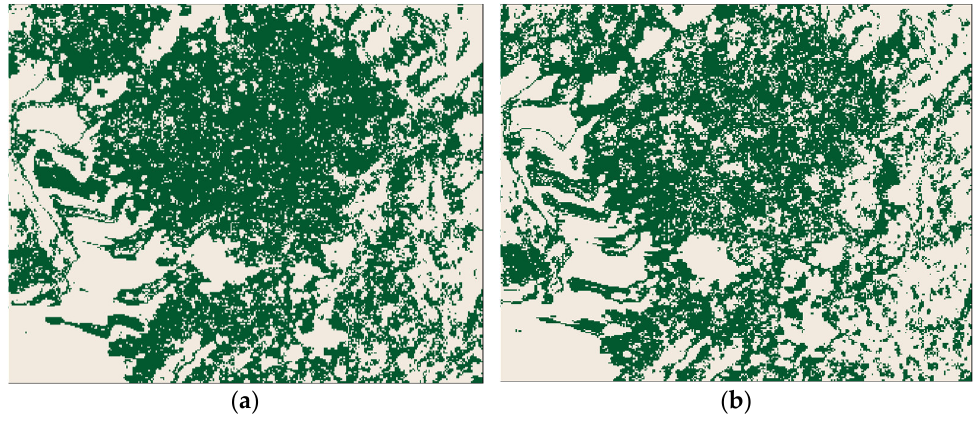
Figure 4. Classification results of garlic and non-garlic areas using k -NN on ( a ) 13 July 2019 and ( b ) 10 November 2019. Note: green indicates the garlic field, and white indicates the non-garlic field. Table 10. Classification model accuracy for datasets A and B.